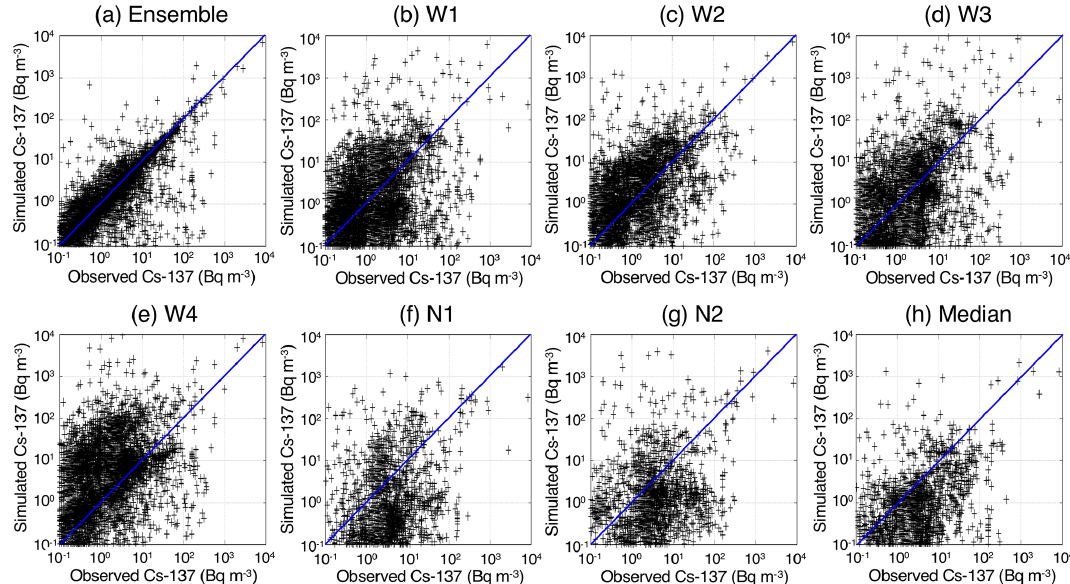
Figure 3. Relationship between the simulated Cs-137 and the observed Cs-137 at all available sites using the (a) ensemble model with all models (W1, W2, W3, W4, N1 and N2), (b–g) original one-member model (W1, W2, W3, W4, N1 and N2) and (h) median model using all models (W1, W2, W3, W4, N1 and N2). The blue line is the 1 : 1 line.